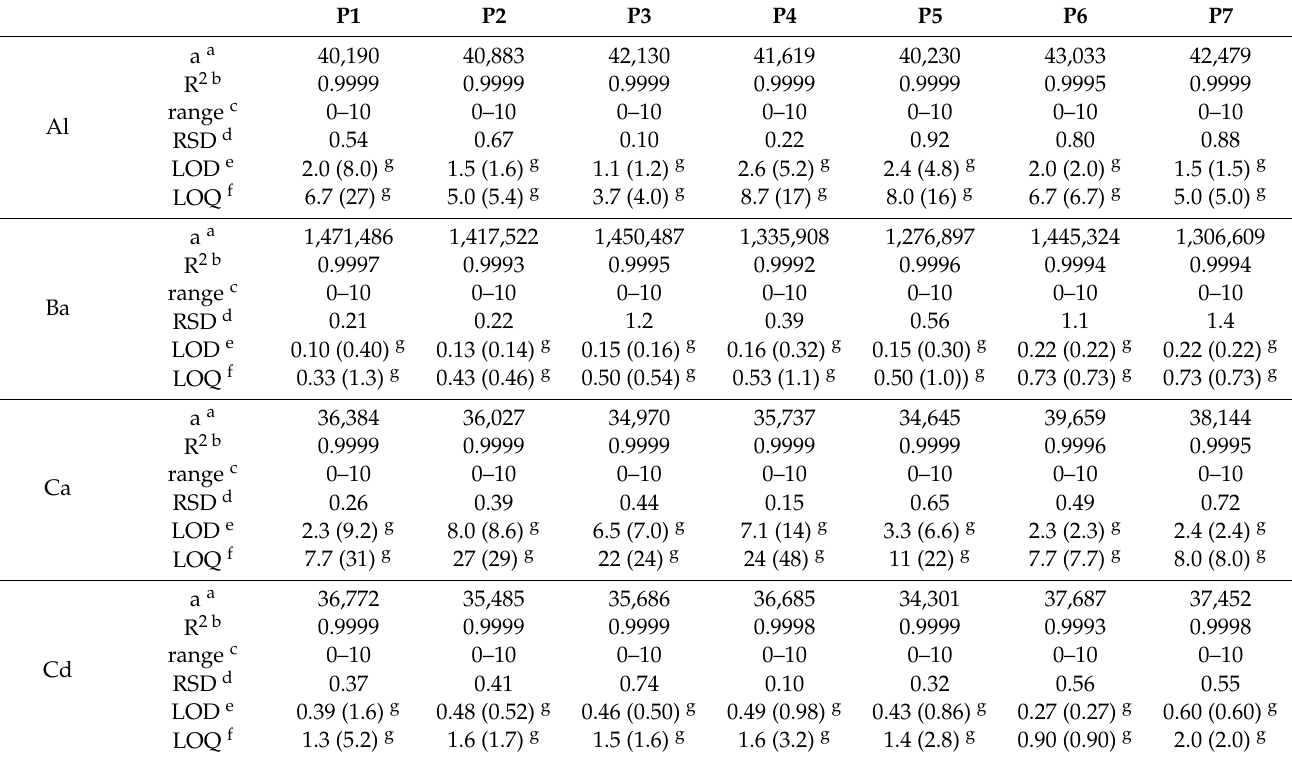
Table 1. Selected figures of merit for the multielement analysis of yerba mate (YM) drinks by ICP-OES assessed considering the external calibration with the matrix-matched and simple aqueous standard solutions for all tested sample preparation procedures